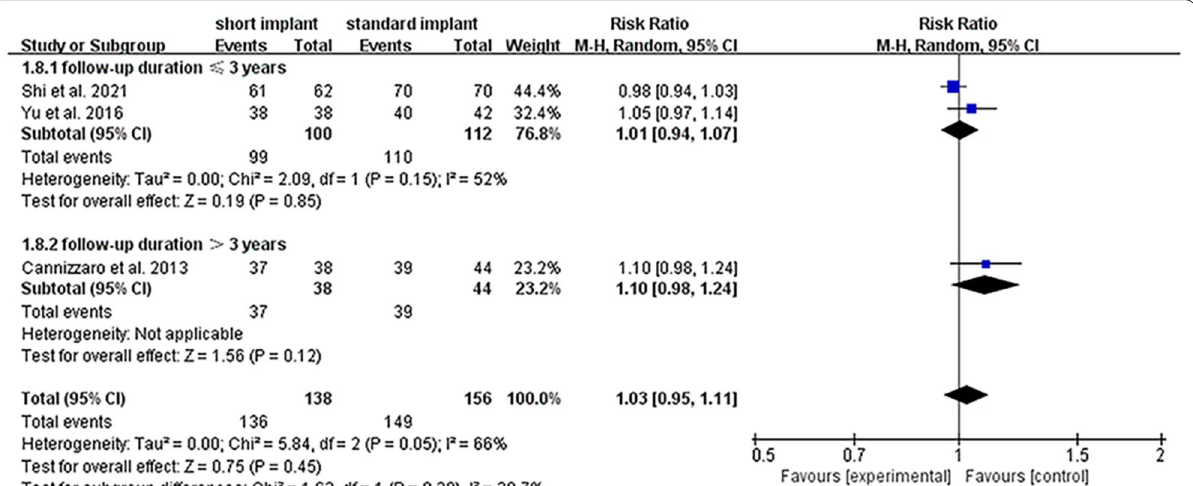
Fig. 5 Subgroup analysis in follow-up duration. The p value of subgroup analysis was higher than the analysis of total studies, showing that the different follow-up durations might be a reason for heterogeneity